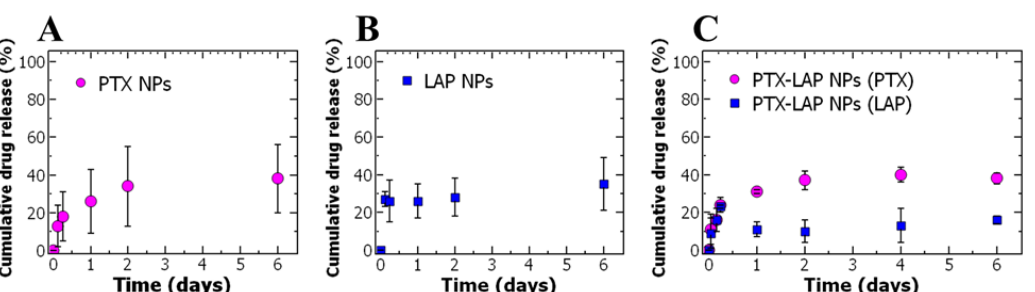
Figure 2. The cumulative drug release of paclitaxel (PTX) and lapatinib (LAP) from polymer nanoparticles (NPs) from ( A ) PTX from PTX NPs, ( B ) LAP from LAP NPs, and ( C ) PTX and LAP from co-loaded nanoparticles. The graph shows the average ± standard deviation of 3 replicates of FNP and independent drug release